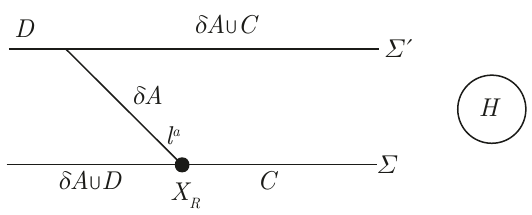
Figure 8 . Here (cid:6) R = C and (cid:6) L = (cid:14)A [ D . The in(cid:12)nitesimal deformation along ‘ a is labeled (cid:14)A and is parametrized by a choice of a(cid:14)ne parameter (cid:21) ‘ along the ‘ a congruence. The ‘ a